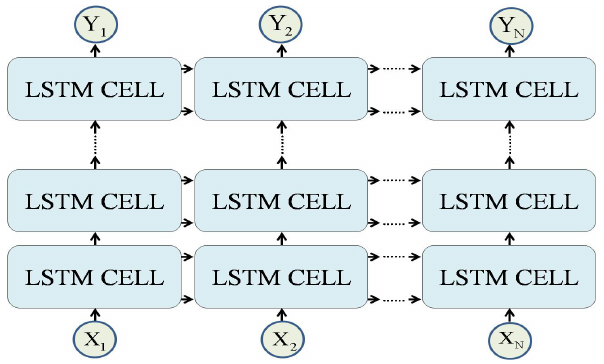
Figure 1. Long short-term memory (LSTM) network